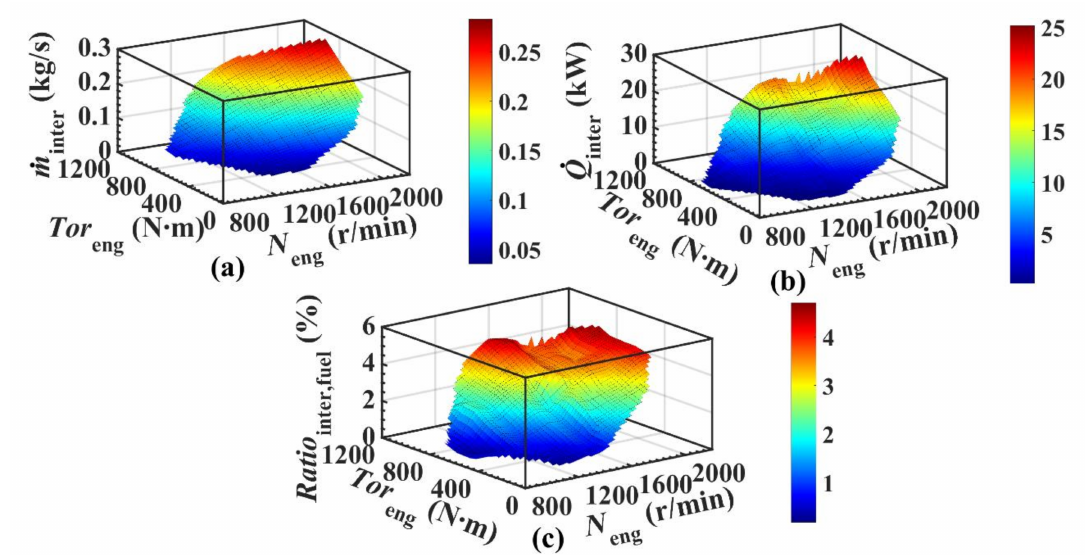
Figure 3. Dynamic characteristics of intercooler waste heat under full operating conditions. ( a ) intercooler mass flowrate distribution characteristics. ( b ) intercooler heat transfer rate distribution characteristics. ( c ) proportion of the intercooler heat transfer rate to the energy released by fuel